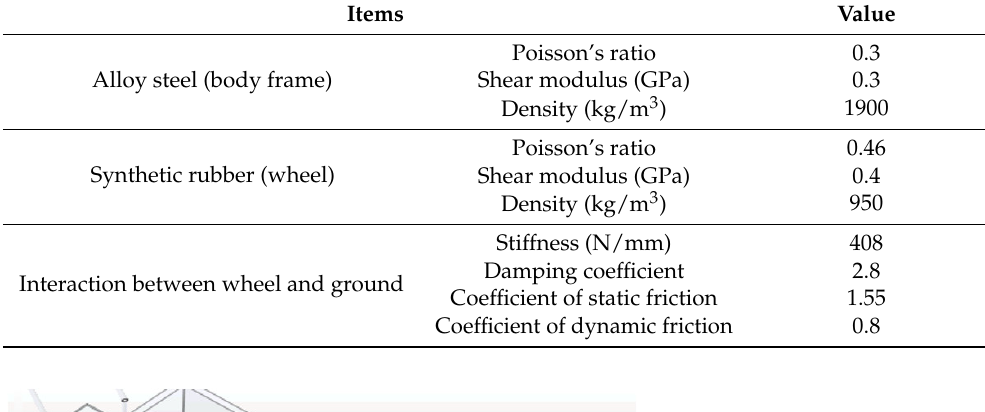
Figure 4. Self-weight of collecting/transferring part.